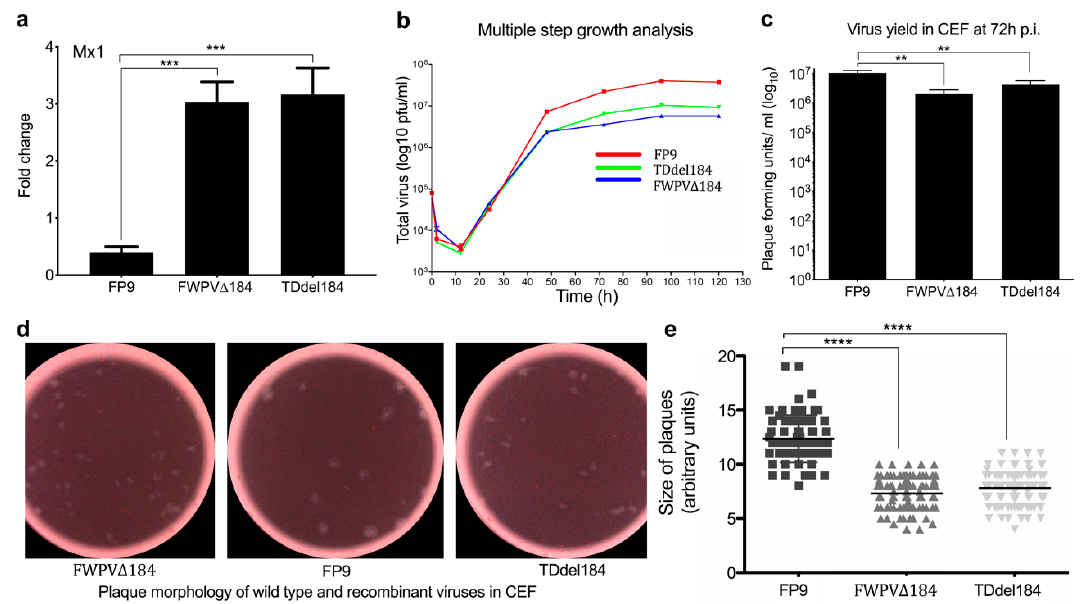
Figure 2. Deletion of FPV184 affects the replicative fitness of the recombinant virus. ( a ) Independent transient dominant (TDdel184) and GPT-insertion FPV184 knockout mutant (FWPV ∆ 184) viruses (MOI (multiplicity of infection): 5, 1 h adsorption) induce similar mRNA levels of Mx1 at 4 h p.i. in CEFs compared to parental FP9 virus by qPCR. ( b ) Multiple-step growth analysis of FP9, FWPV ∆ 184 and TDdel184 viruses in CEFs (MOI: 0.01). ( c ) Viral yield of FP9, FWPV ∆ 184 and TDdel184 viruses (in pfu / mL) following 72 h infection with an MOI of 0.1 in CEFs. ( d ) Images of viral plaques of FP9, FWPV ∆ 184 and TDdel184 viruses in CEFs. ( e ) Scatterplot showing their respective size in arbitrary units. ( a – e ) Error bars indicate standard error of the mean (SEM); n = 3. One-way ANOVA with Dunnett’s post hoc test was used to analyse the data. ** p < 0.01, *** p < 0.001, **** p < 0.0001.